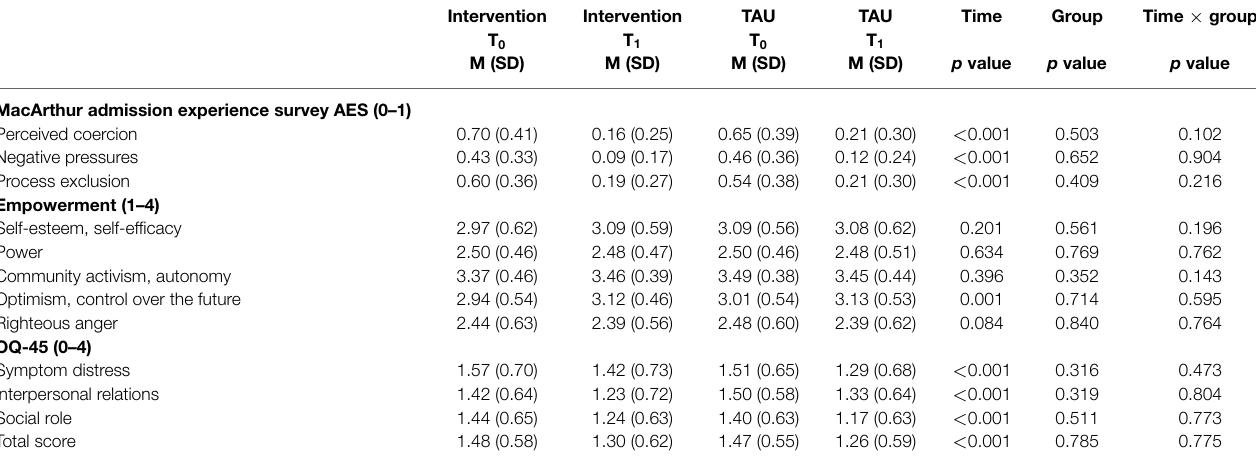
p-values empowerment, OQ-45: repeated measurement variance analysis; p-values perceived coercion: Mann–Whitney U tests and Wilcoxon